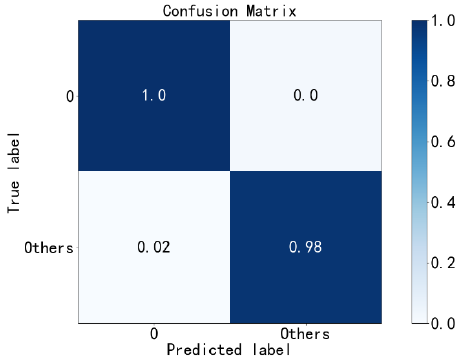
Figure 10. First fault diagnosis with the PE method. Second, the IRFs with three different fault diameters (labels 1~3) are diagnosed, and remaining fault states are labeled as others. The confusion matrix of the second diagnosis the samples of all diagnosed IRFs are eliminated from the test set.